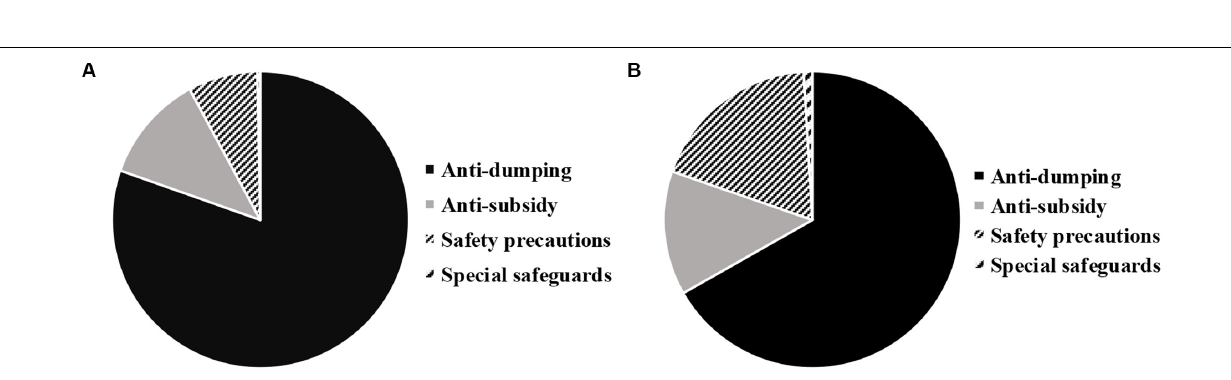
FIGURE 3 | Change trends of total number of the global and China-related trade frictions from 2009 to 2019.